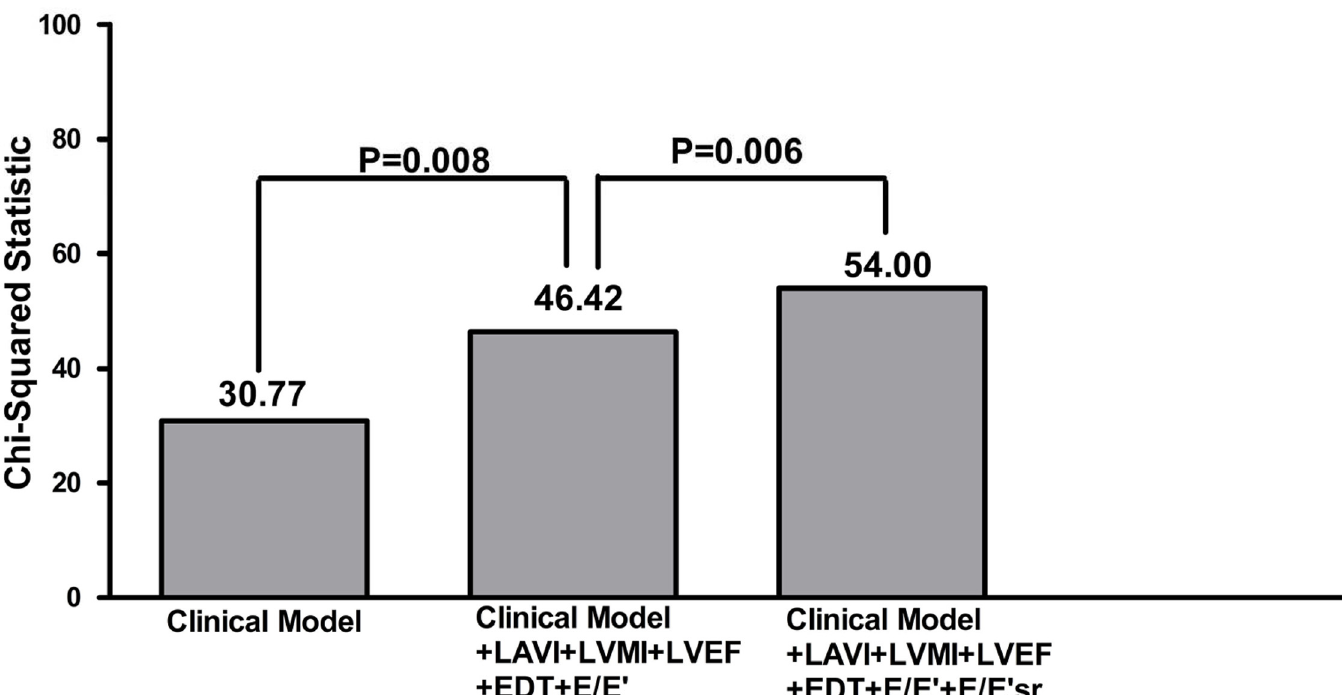
Fig 2. Addition of the ratio of E to E ’ sr to a Cox model including clinical variables, LAVI, LVMI, LVEF, EDT and E/E ’ resulted in a significant improvement in the prediction of progression to renal end point of ≧ 25% decline in eGFR ( p =